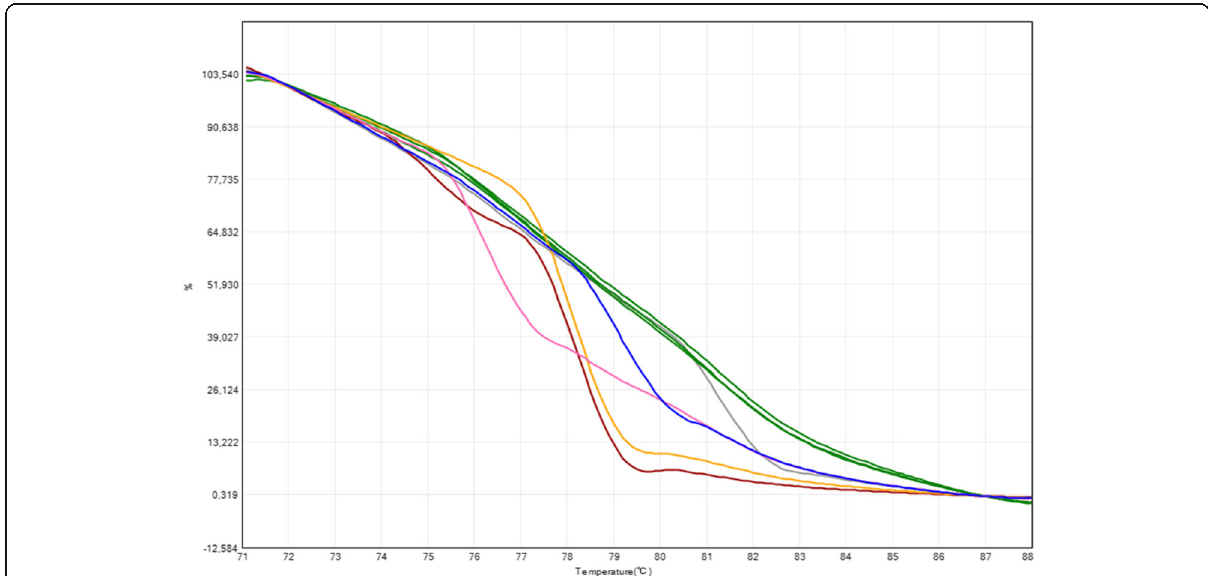
Fig. 4 Determination of the genotype of the sample in the mutant allele specific multiplex PCR. Melting curves obtained at a ramp rate of 0.01 °C/s. Each color represents a genotype: green (non-carrier), blue (R553X), pink (3120+1G>A), brown (F508/N1303K), grey (R334W) and yellow (G542X).